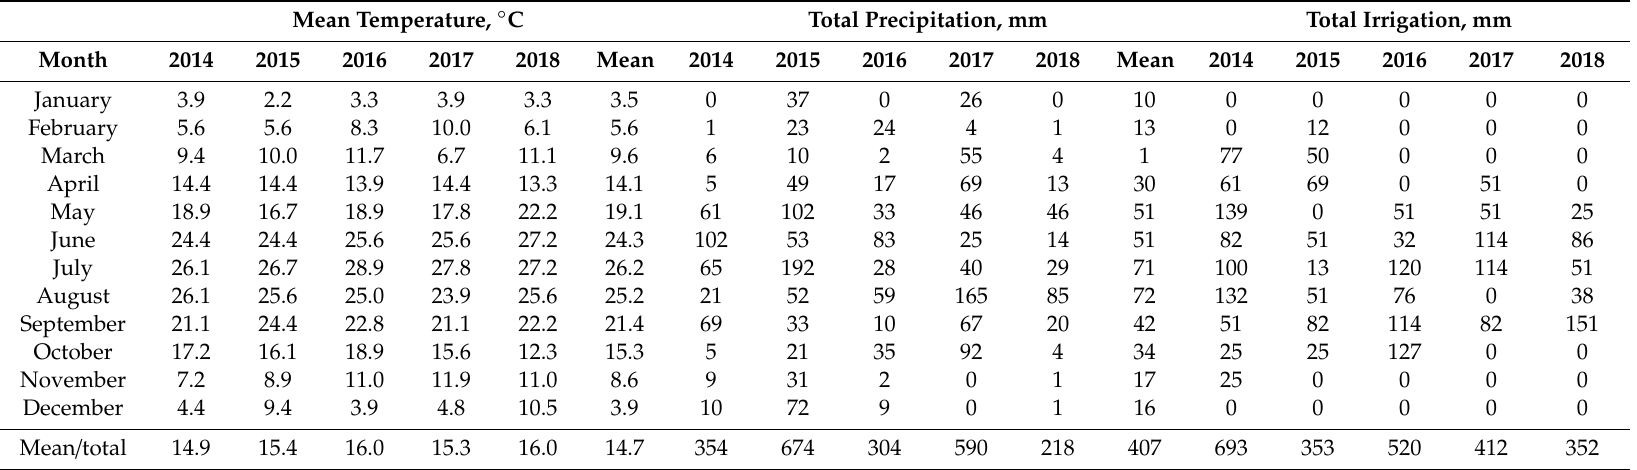
Table 1. Temperature and precipitation from 2014 to 2018 at Tucumcari, NM, and the long-term means (1905 to 2017) and irrigation amounts applied to Bassia prostrata using treated municipal